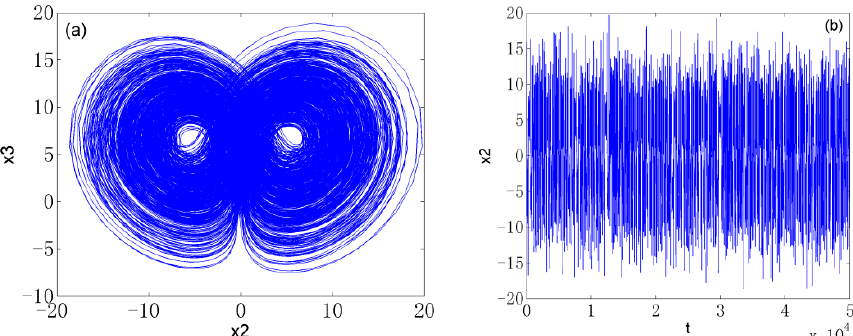
Figure 2. Chaotic attractor of system (2) when 𝑐 (cid:3404) (cid:3398)6.8 . ( a ) Phase portrait; ( b ) time evolution curve.